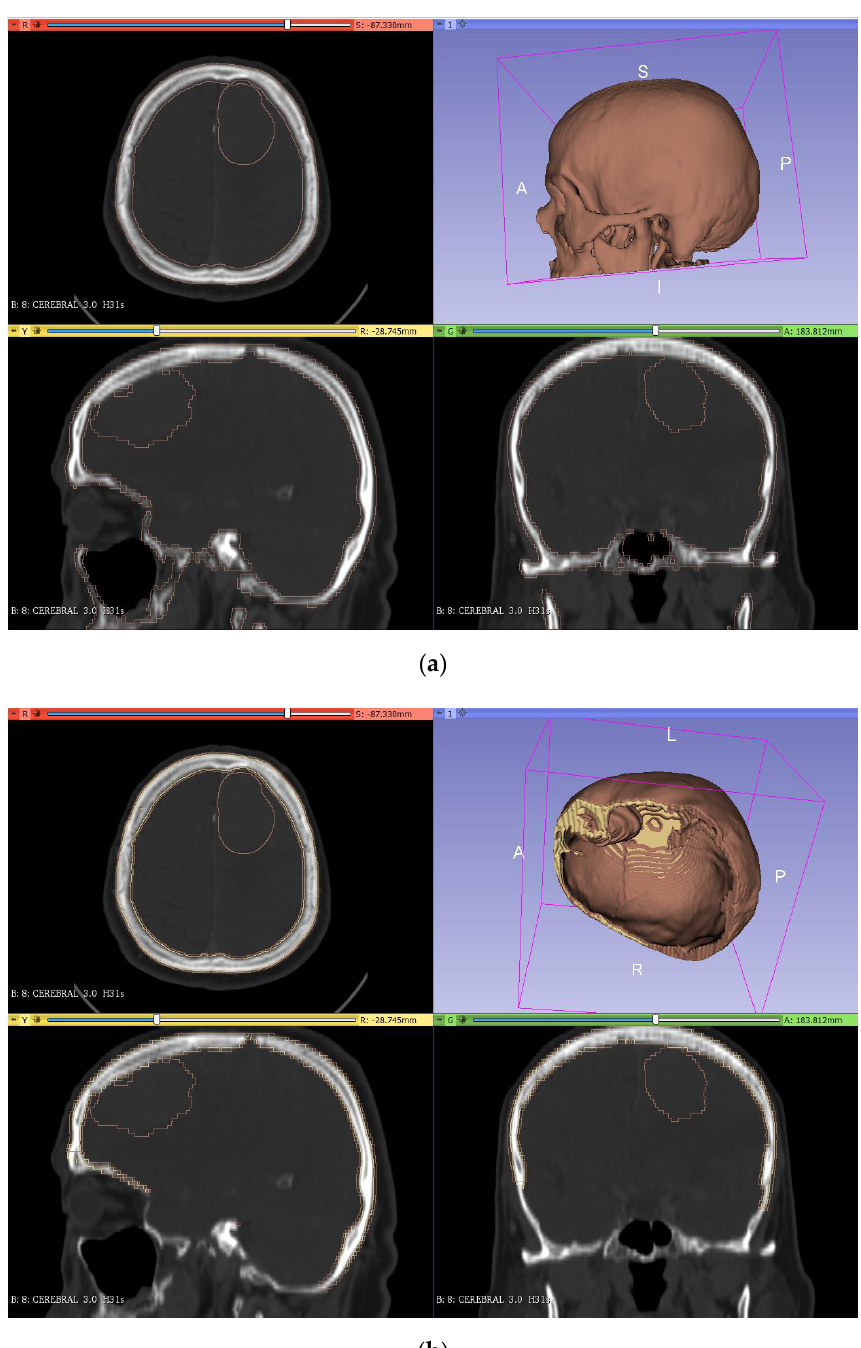
Figure 4. Segmentation ( a ) and creation of the brain mold ( b ) from the DICOM images in 3DSlicer. Once all the models were segmented in 3DSlicer, they were imported into Meshmixer software to be converted into a solid STL file (‘make solid’ feature, in the edit